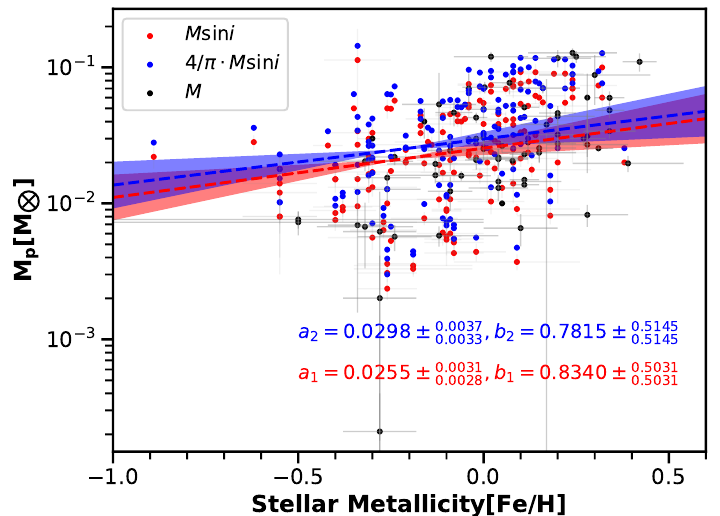
Figure 6. The scatter plot of planetary mass versus metallicity. The mass is given in different ways. The black dots mark those from accurate measurements, M; the red dots mark the Msin i measurement value, while the blue dots mark data points of Msin i multiplied by 4/ π . The red and blue dashed lines represent the fitting curve from linear regression for the sample of M and Msin i and M &4/ π · Msin i , respectively, as do the texts and the shadow regions (95% confidence interval) in two